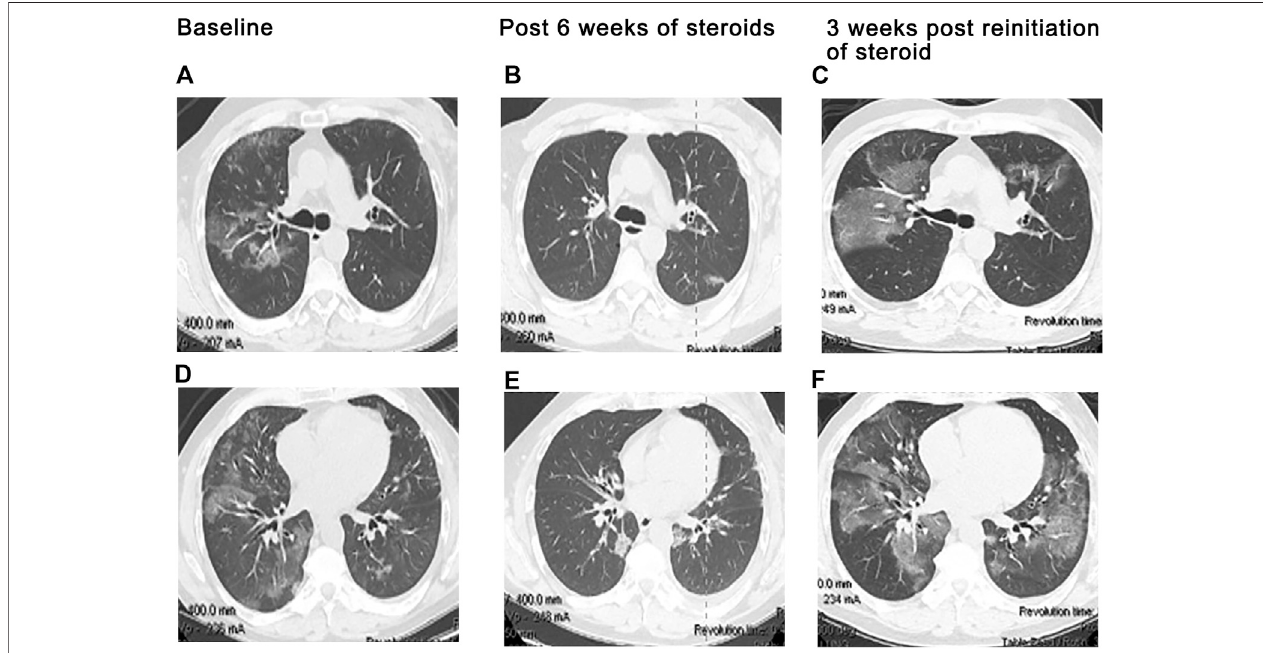
FIGURE 1 | Exacerbation of preexisting interstitial lung disease. A 68 year-old man with ahistoryof mild idiopathic pulmonary fi brosis and prostate cancer. Severe dyspnea and cough developed 19 days following cycle 1 of ipilimumab plus hormonal therapy, given per protocol. Chest CT at baseline (A,C) demonstrates subpleural ground glass and reticular opacities consistent IPF. CT imaging at presentation (B,D) shows interval development of poorly marginated scattered consolidative and ground glass opacities consistent with pneumonitis. In addition, there is bilateral diffuse thickening of the interlobular septa associated with architectural distortion suggesting progression of underlying fi brosis. Findings suggest that even mild preexisting lung disease may potentiate severe pneumonitis and worsening fi brotic disease following ICI therapy.